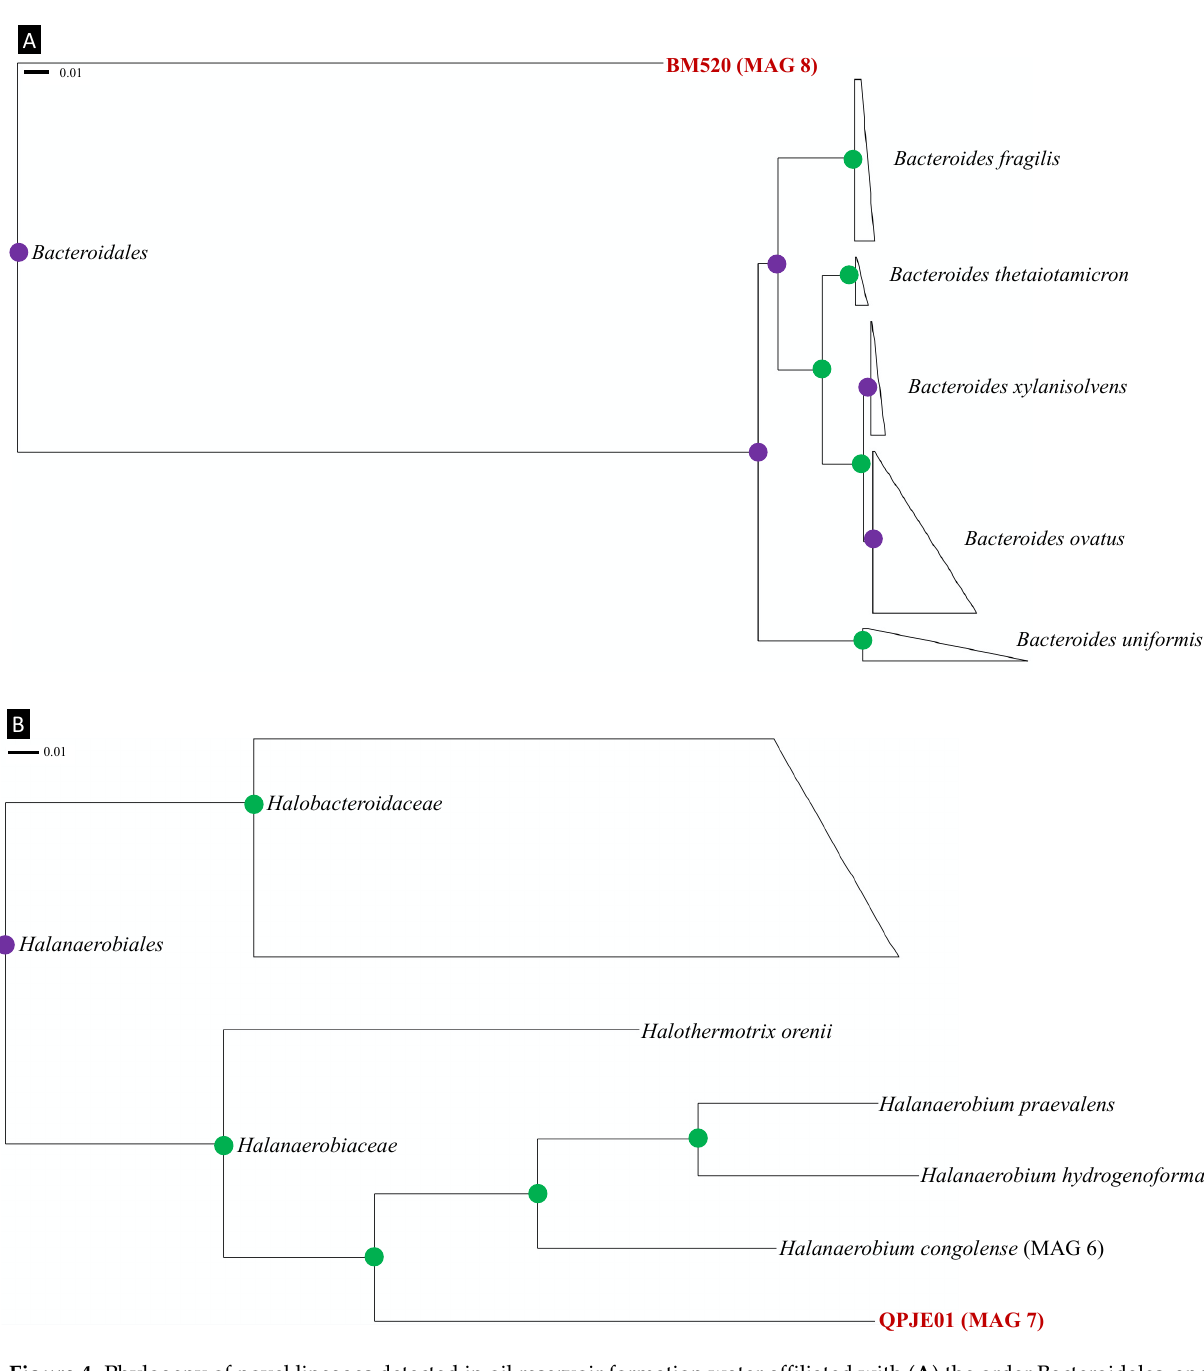
Figure 4. Phylogeny of novel lineages detected in oil reservoir formation water affiliated with ( A ) the order Bacteroidales, and ( B ) the family Halanaerobiaceae. The tree is based on CheckM phylogeny and only shows selected lineages from the orders Bacteroidales and Halanaerobiales. Green circles represent bootstrap values of 1.000 and purple circles represent bootstrap values between 0.900 and 0.999. Novel organisms are highlighted in bold red. The scale bars indicate 1% sequence divergence.